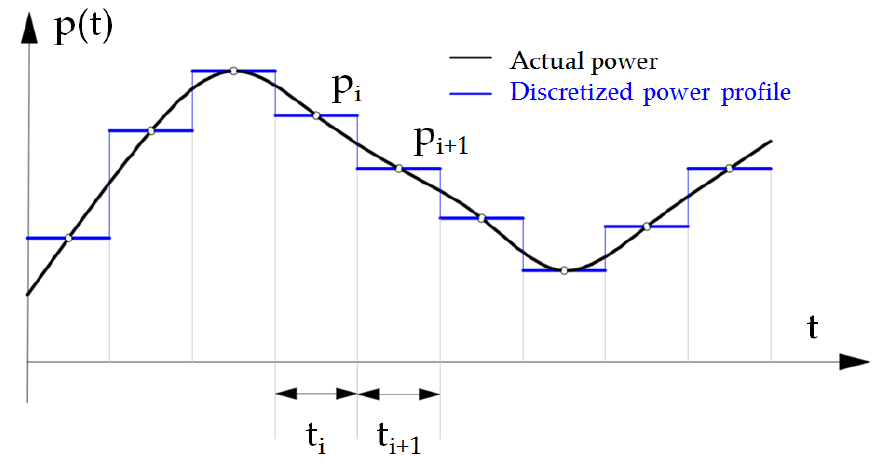
Figure 1. Actual and discretized power profiles.